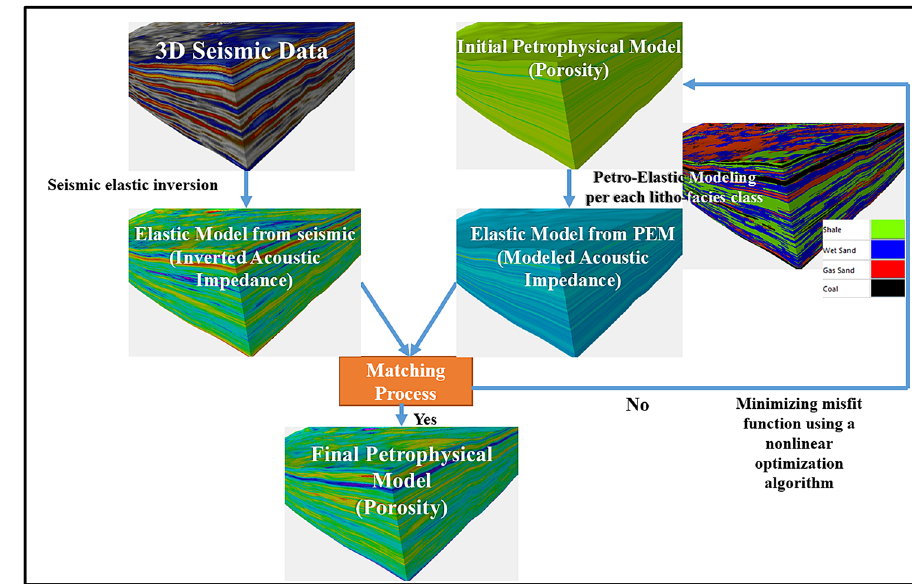
Fig. 1 Proposed workflow